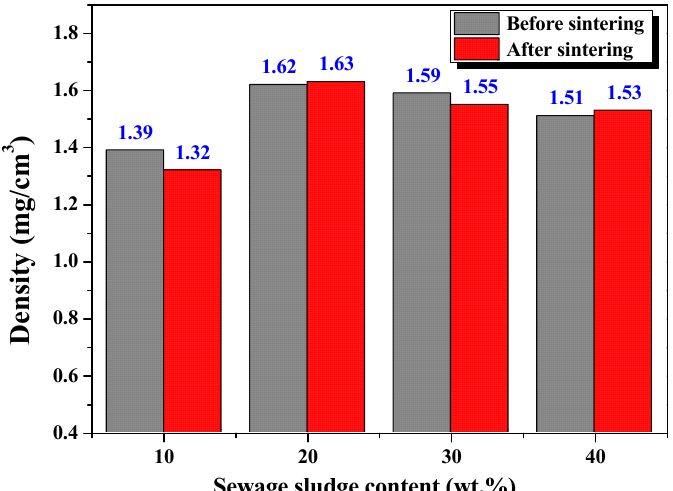
Figure 4. Apparent density of the ceramic bricks with various sewage sludge contents.